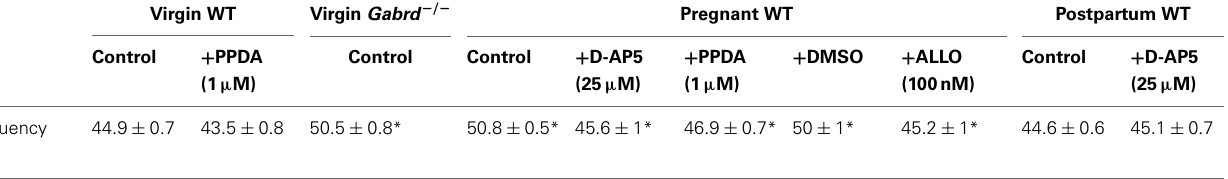
Table 1 | Details of γ oscillations characteristics by gestational state and genotype. Virgin WT